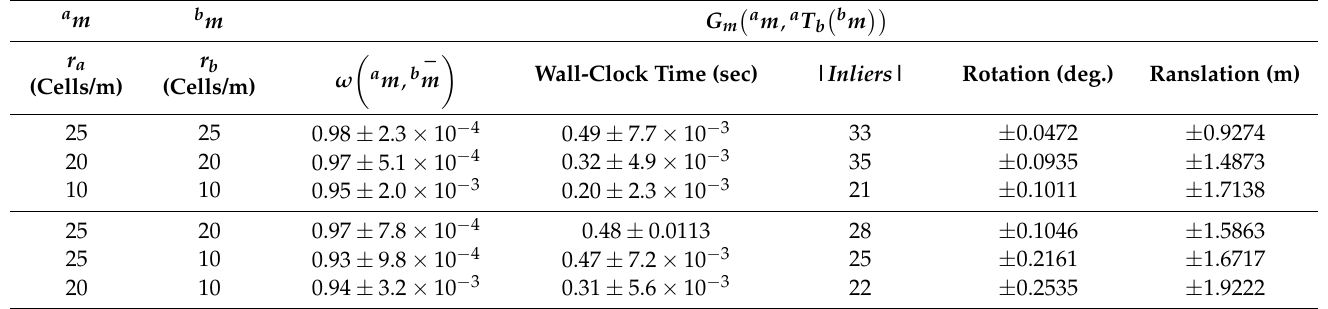
Table 1. Mean and deviation of performance parameters while merging maps of same and different grid resolutions.